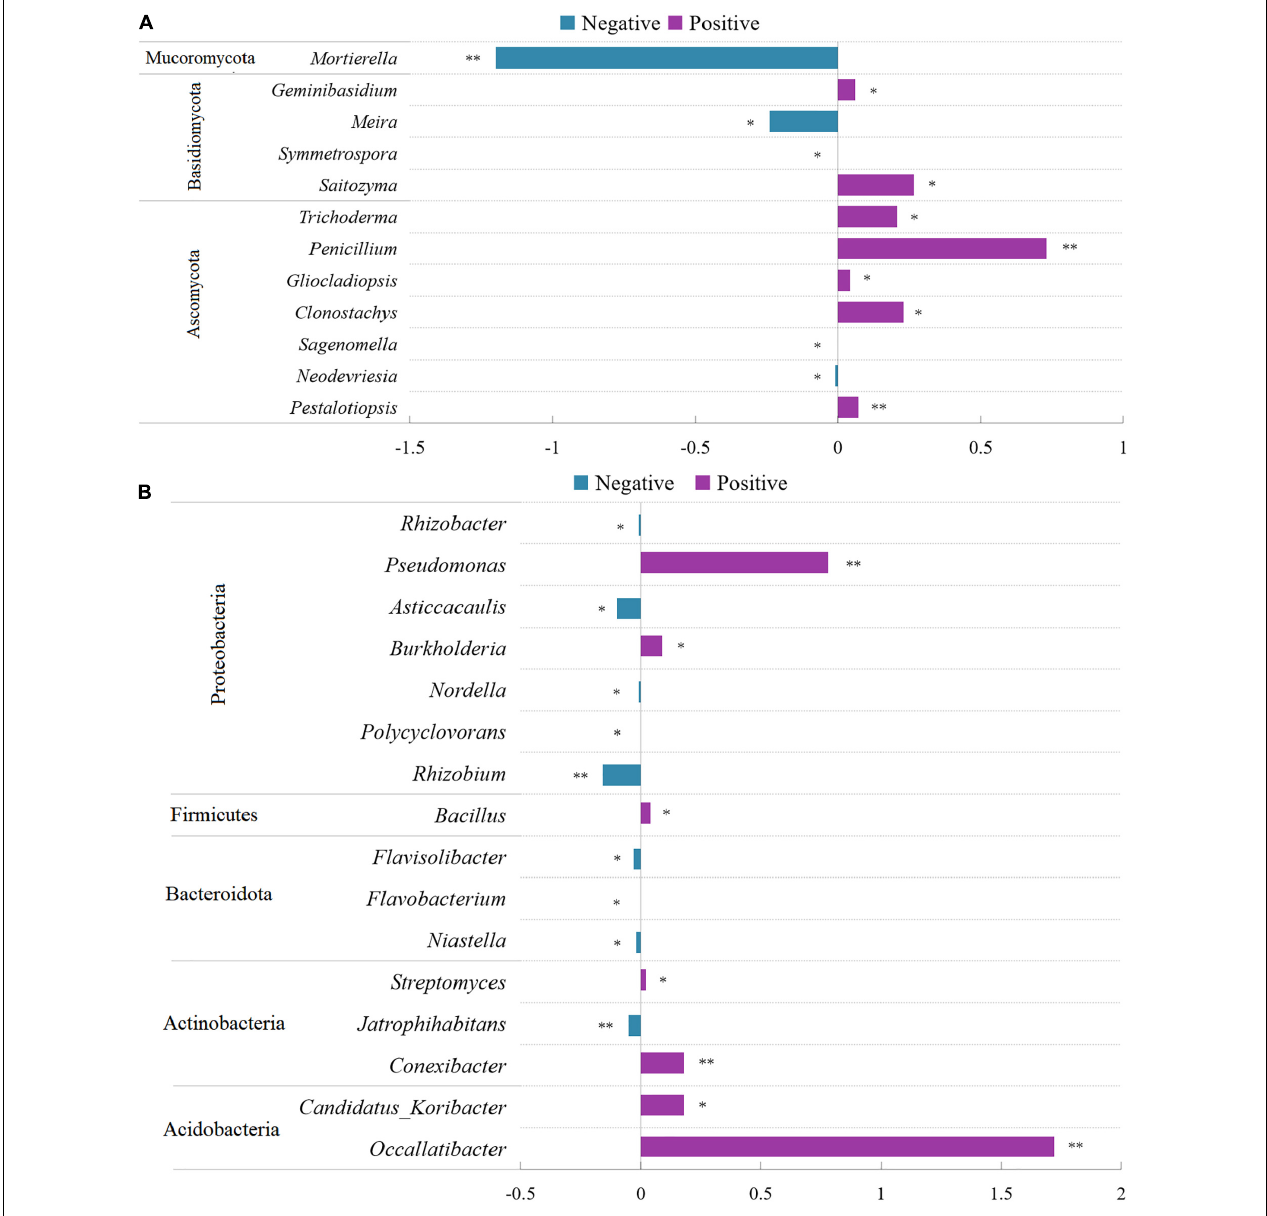
FIGURE 4 | Comparison of fungi (A) and bacterial (B) abundance differences between conditioned and control rhizosphere soils at the genus level. Data are means ± SEs. ∗ p < 0.05, ∗∗ p < 0.01 vs. control soil.